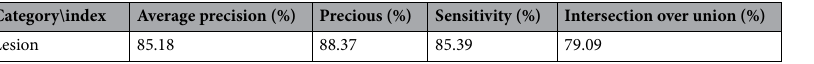
Table 5. The detection performance of lesion samples for the binary classification task. 85% lesion areas can be detected by the proposed two-branch networks.